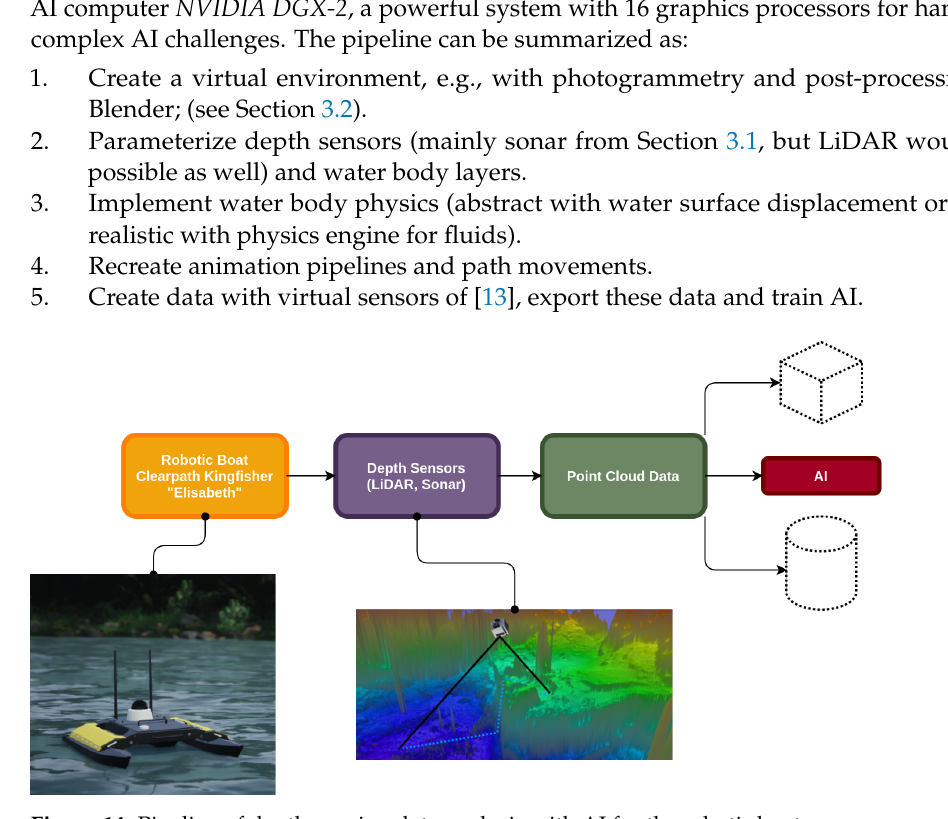
Figure 14. Pipeline of depth-sensing data analysis with AI for the robotic